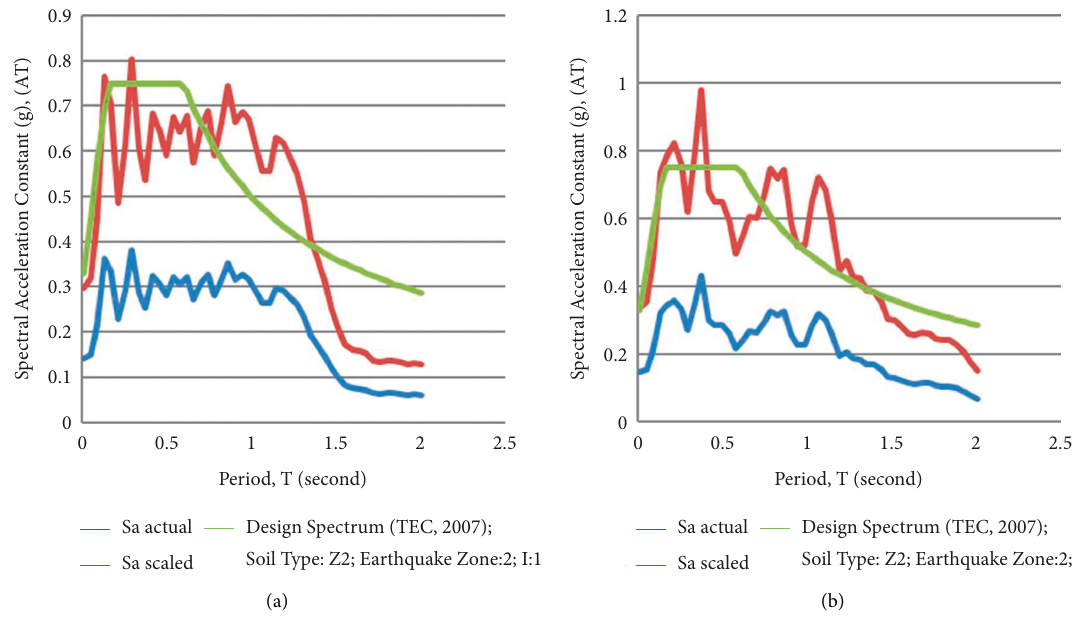
Figure 16: Evaluation of A(T) spectral acceleration constants at S. Kochisar station for (a) North-South (N-S) and (b) East-West (E-W) components of earthquake with epicenter at Kayseri-Kocasinan ( M L : 4.8).